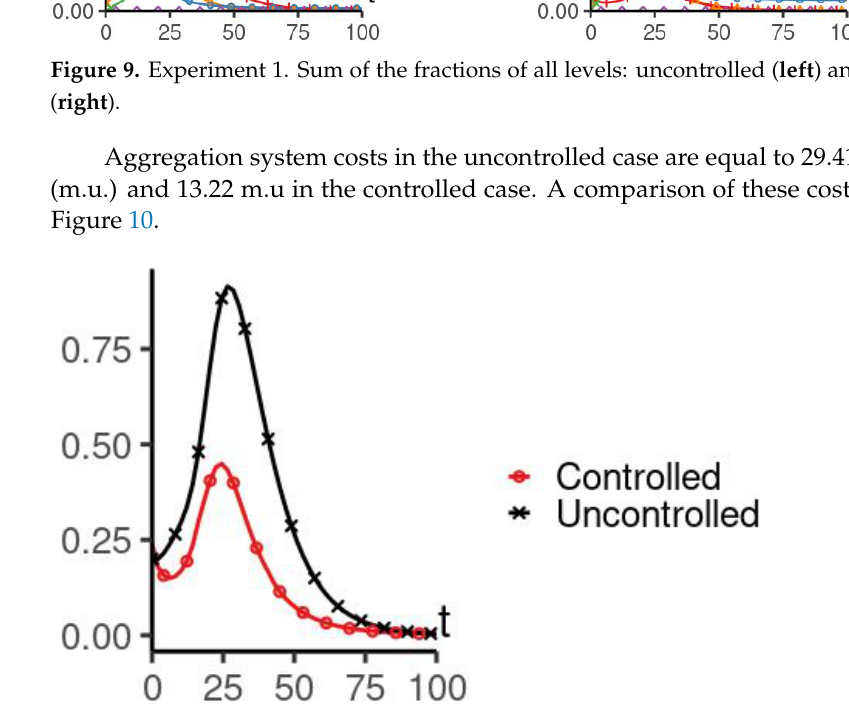
Figure 10. Experiment 1. Aggregation costs in uncontrolled and controlled cases.